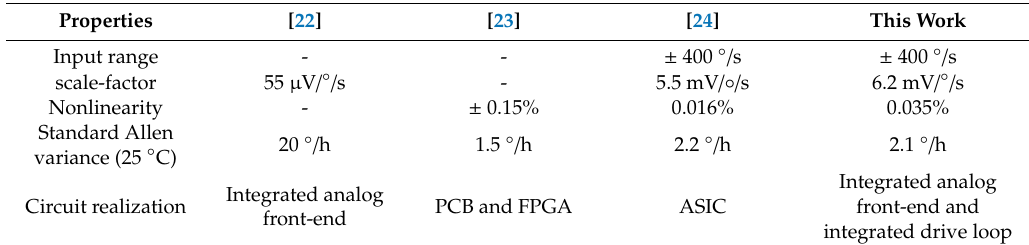
Table 2. Properties summary and comparison.